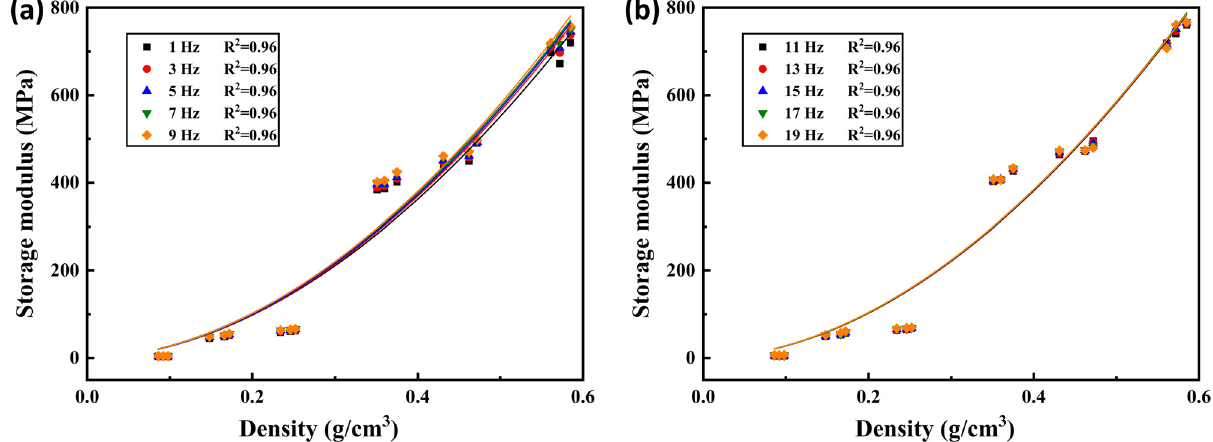
Figure 10: Relationship between density and storage modulus of polyurethane grounding materials ( 25°C ) : ( a ) fi tting results ( 1 – 9 Hz ) and ( b ) fi tting results ( 11 – 13 Hz )